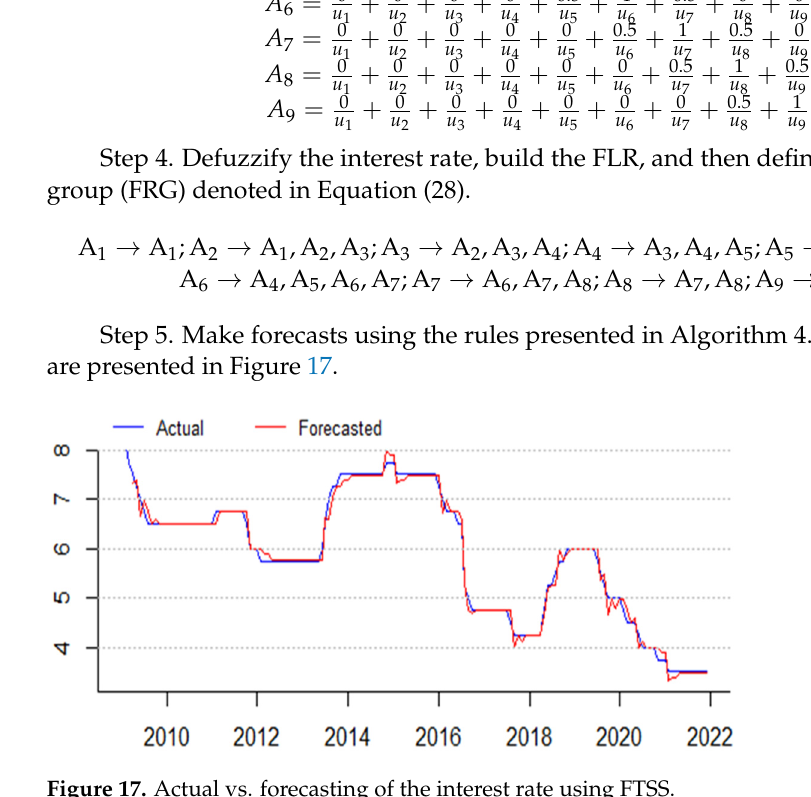
Figure 17. Actual vs. forecasting of the interest rate using FTSS.